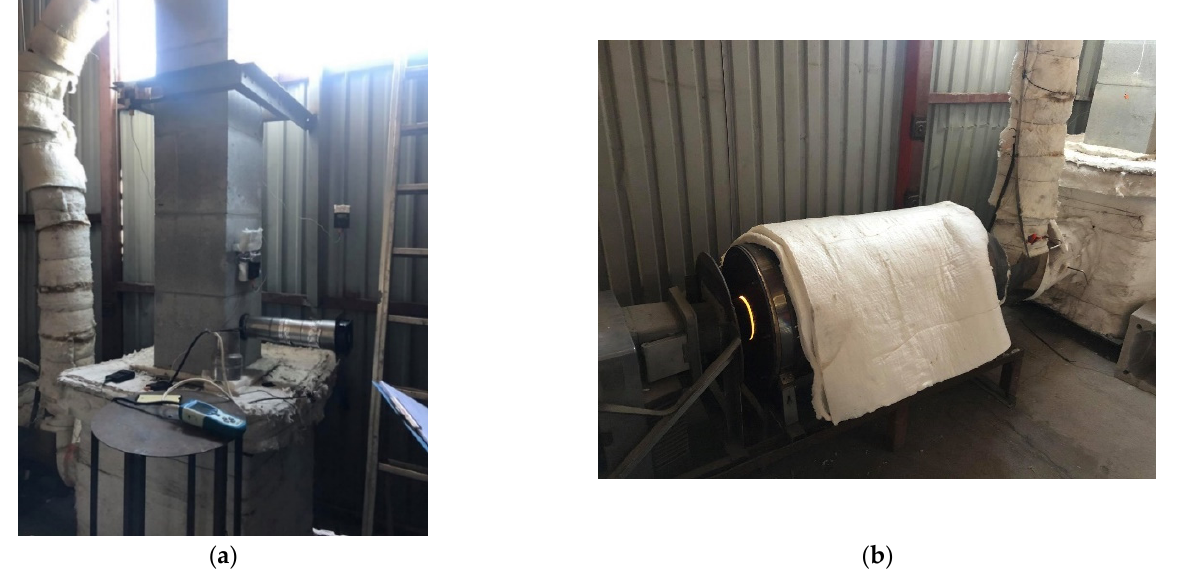
Figure 7. Stand used for fire testing: ( a ) tested chimney on the testing chamber and ( b ) hot exhaust generator.